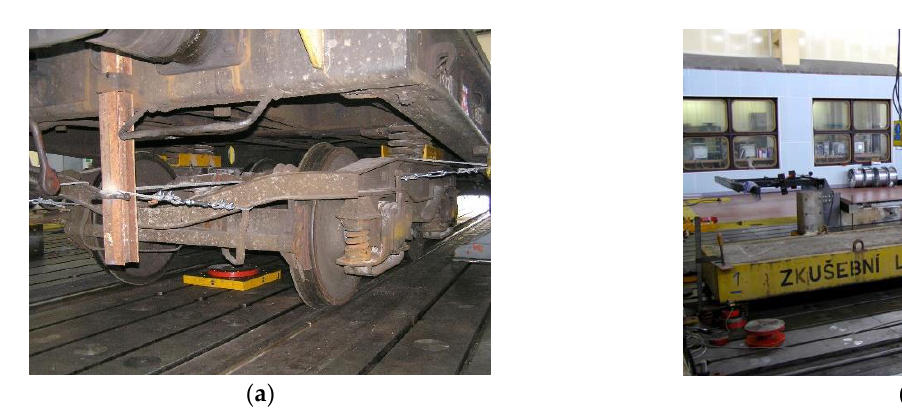
Figure 3. Chassis support: ( a ) Original springs; ( b ) substituted springs. The bogies were fixed to the body (car platform) by a network of steel cables with cable tensioners—Figure 4a.